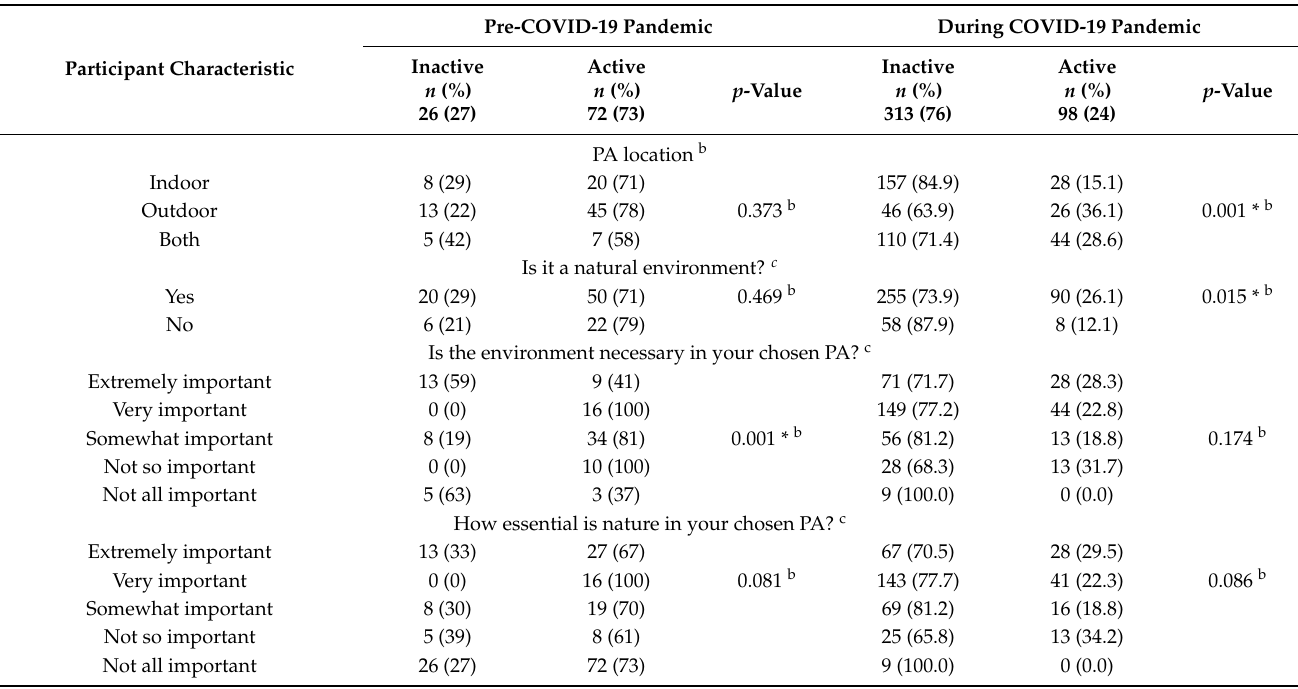
Table 3. Summaries of the results of indoor and outdoor physical activity behavior in active and inactive